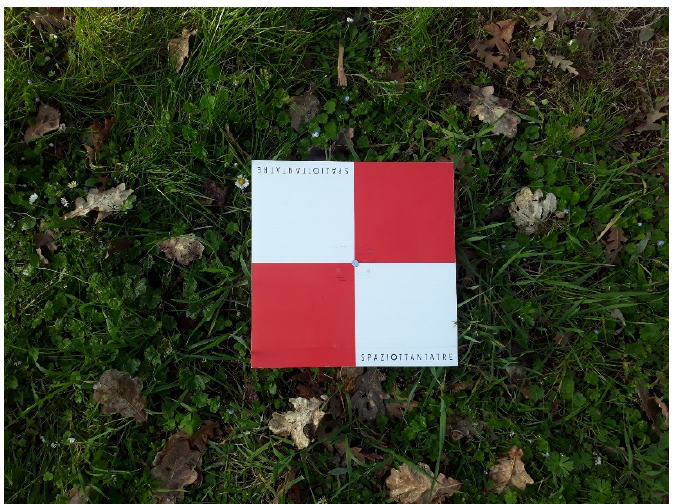
Figure 4. Ground target. Figure 4. Ground